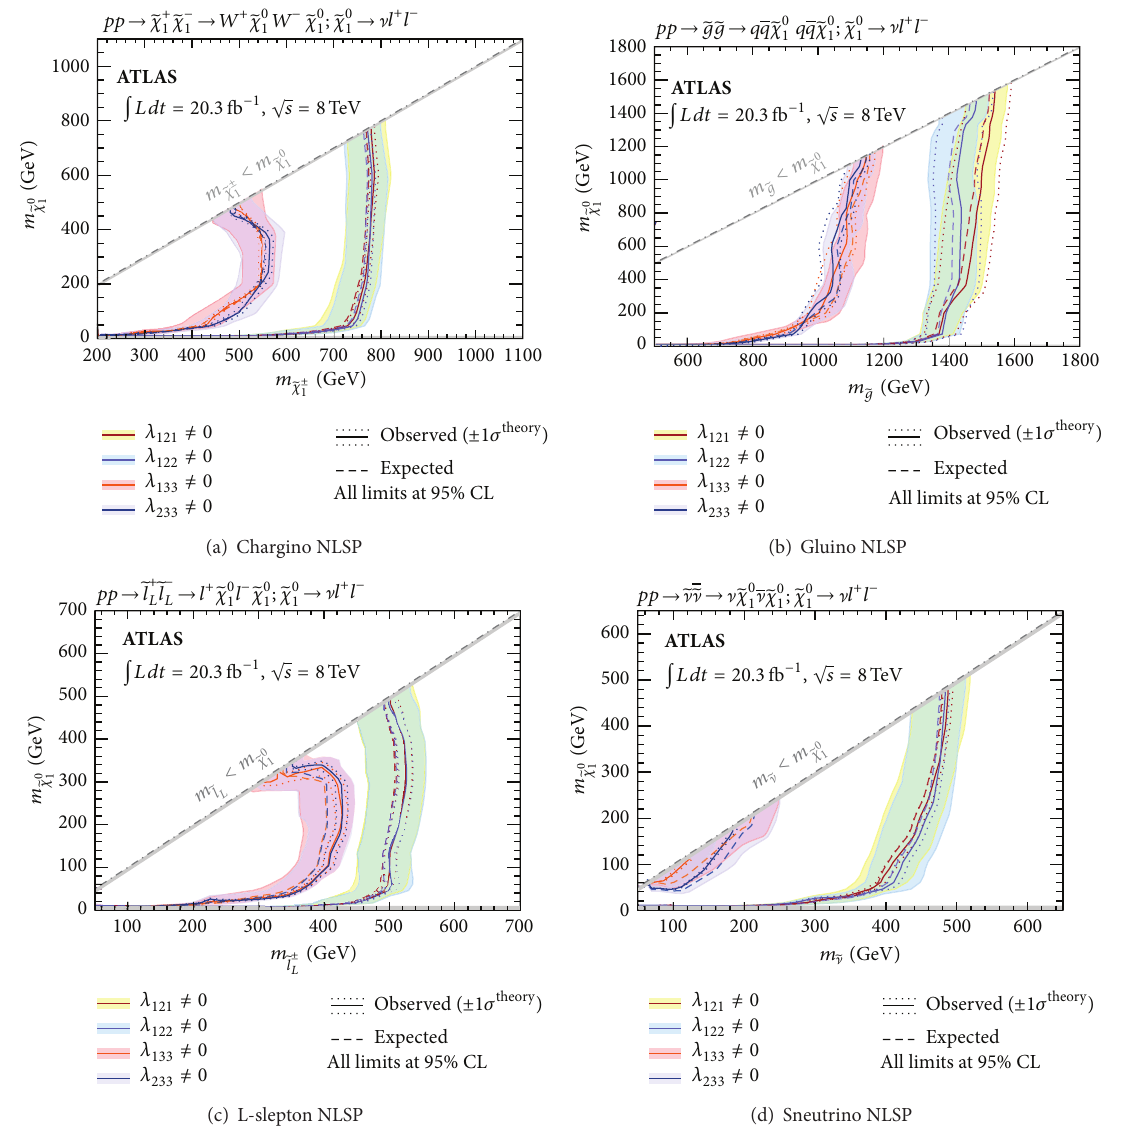
Figure 4: Observed and expected 95% CL exclusion limit contours for the 𝐿𝐿𝐸 RPV (a) chargino NLSP, (b) gluino NLSP, (c) left-handed slepton NLSP, and (d) sneutrino NLSP simplified models (from